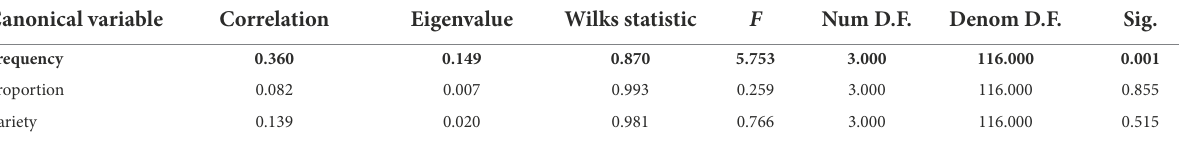
TABLE 5 Summary of the canonical correlation analyses: FSs and breakdown fluency. Canonical